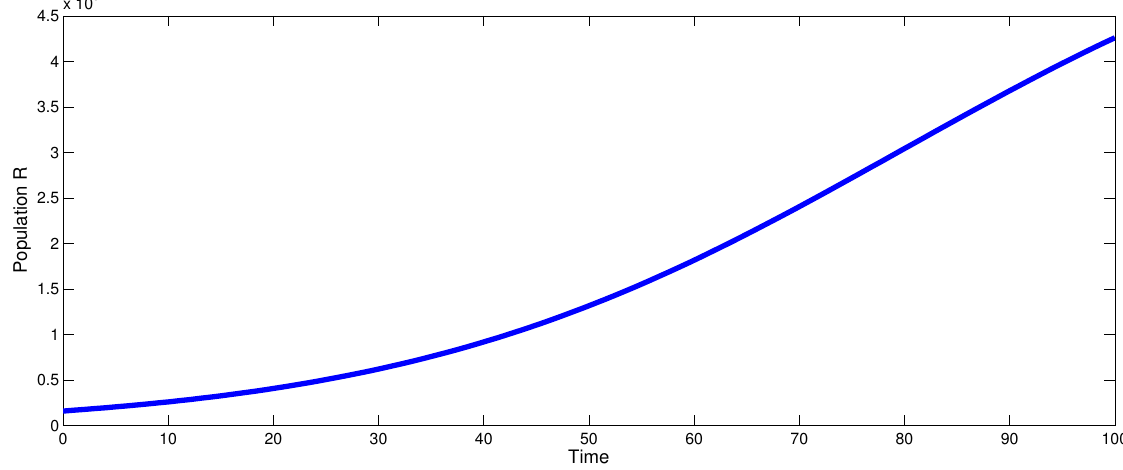
Fig. 9. Diagram for the infected populace ( I ) without control using data from Tables 1, 2 and G 1 = 0 . 005 , G 2 = 1000 from 30 / 4 / 2020 to 7 / 8 / 2020 .